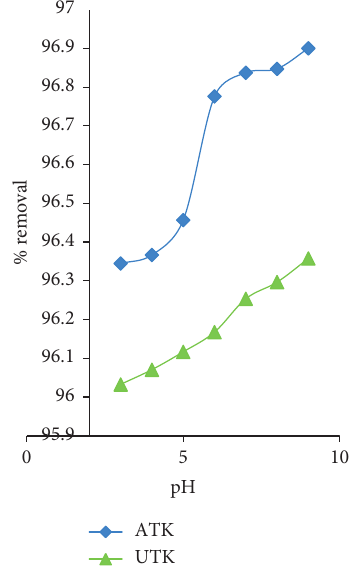
Figure 4: % removal of Cd (II) ions versus